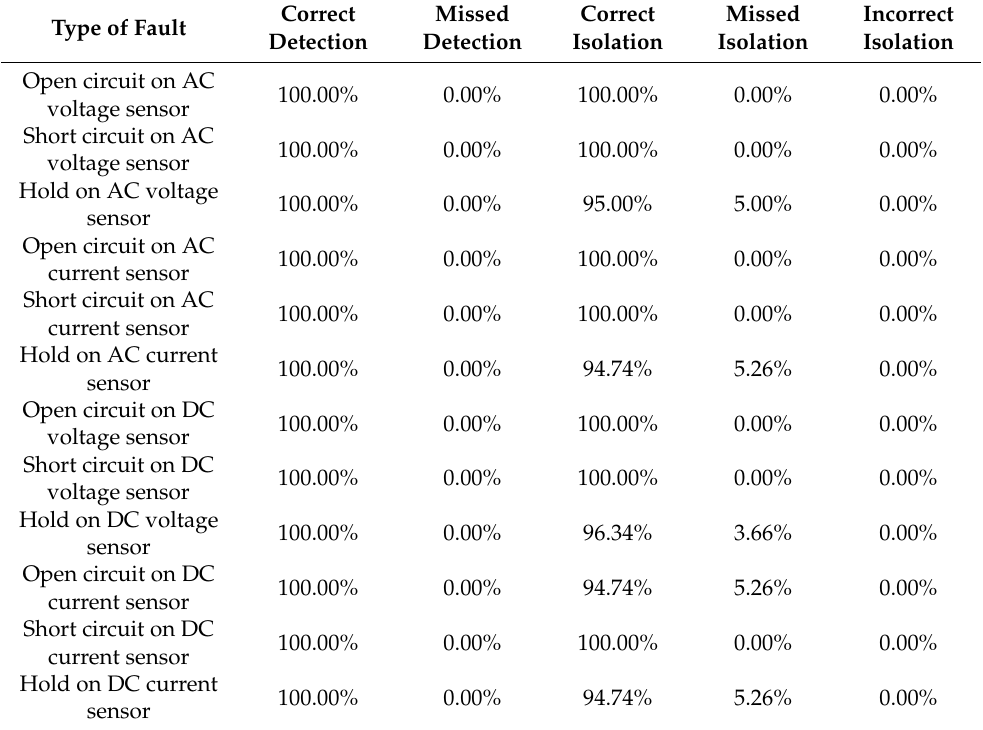
Table 7. The IFDI diagnostic performance.